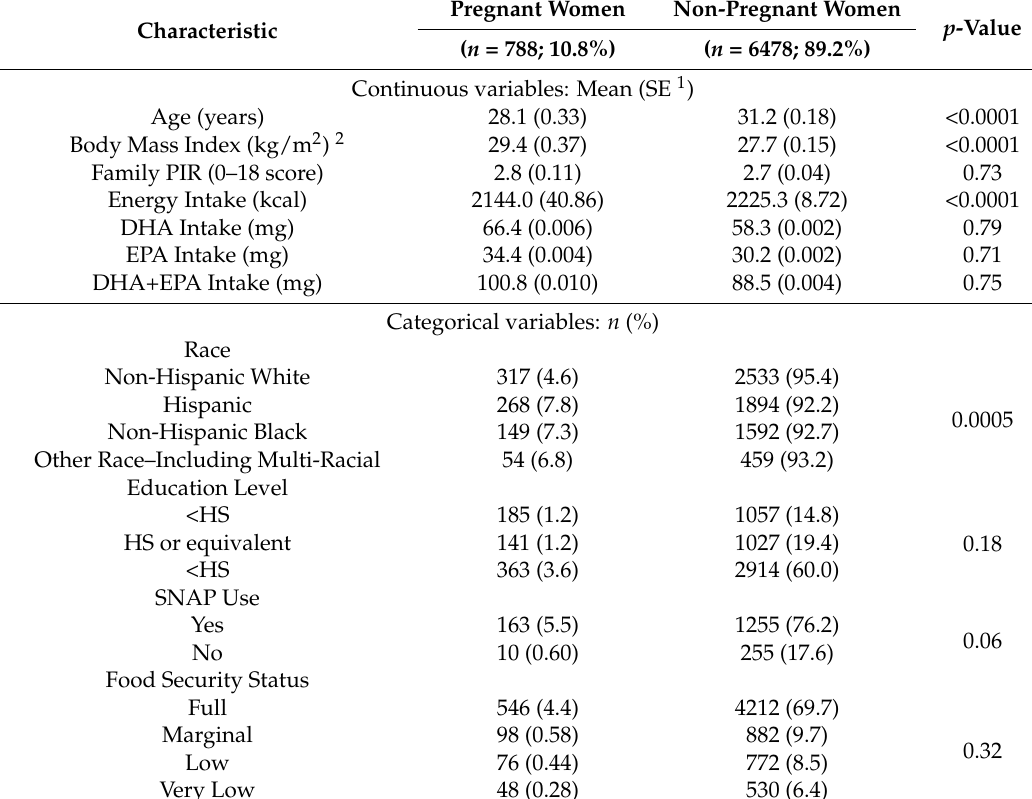
Table 1. Participant characteristics by pregnancy status.